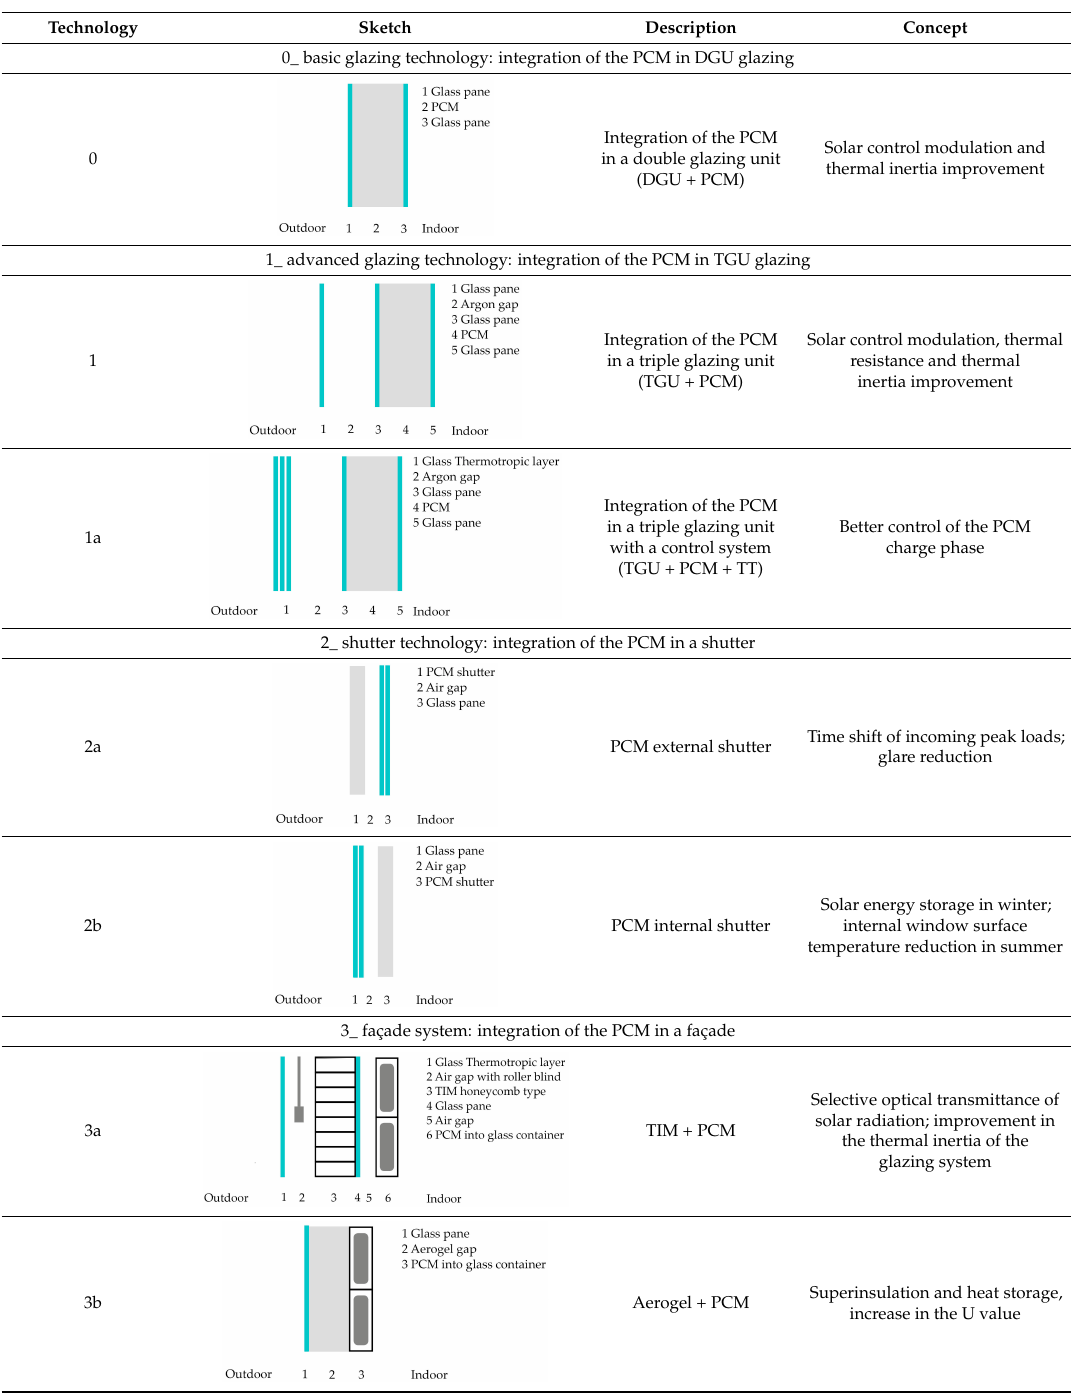
Table 1. Technologies integrating PCM in transparent envelopes. Table 1 . Technologies integrating PCM in transparent envelopes. Table 1 . Technologies integrating PCM in transparent envelopes. Table 1 . Technologies integrating PCM in transparent envelopes. Table 1 . Technologies integrating PCM in transparent envelopes. Table 1 . Technologies integrating PCM in transparent envelopes. Table 1 . Technologies integrating PCM in transparent envelopes. Table 1 . Technologies integrating PCM in transparent